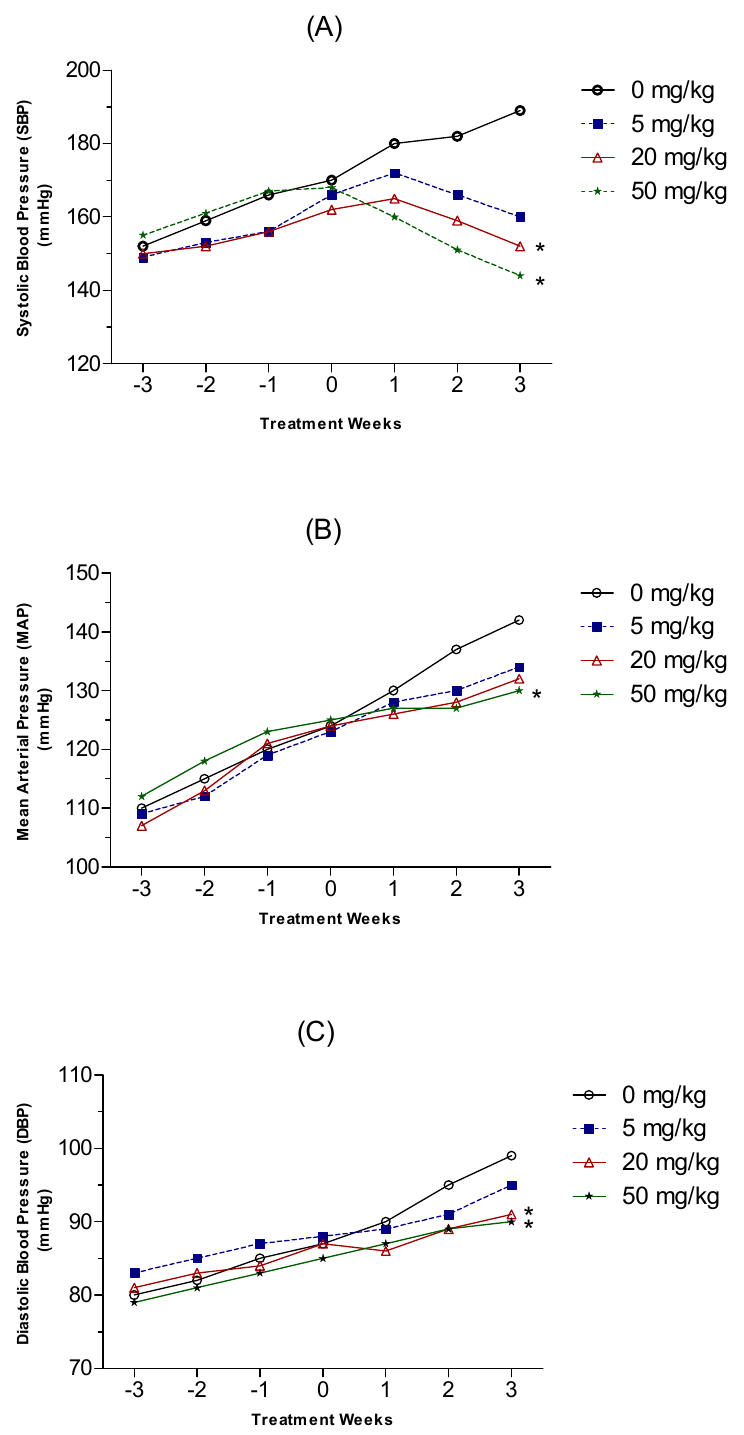
Figure 3. Average weekly systolic ( A ), mean arterial ( B ), and diastolic ( C ) blood pressure of control and HON-treated spontaneously hypertensive male rats (SHR) during the three-week study period. Data are presented as mean ± SD ( n = 8). * indicates significant difference, lower or higher, from control.